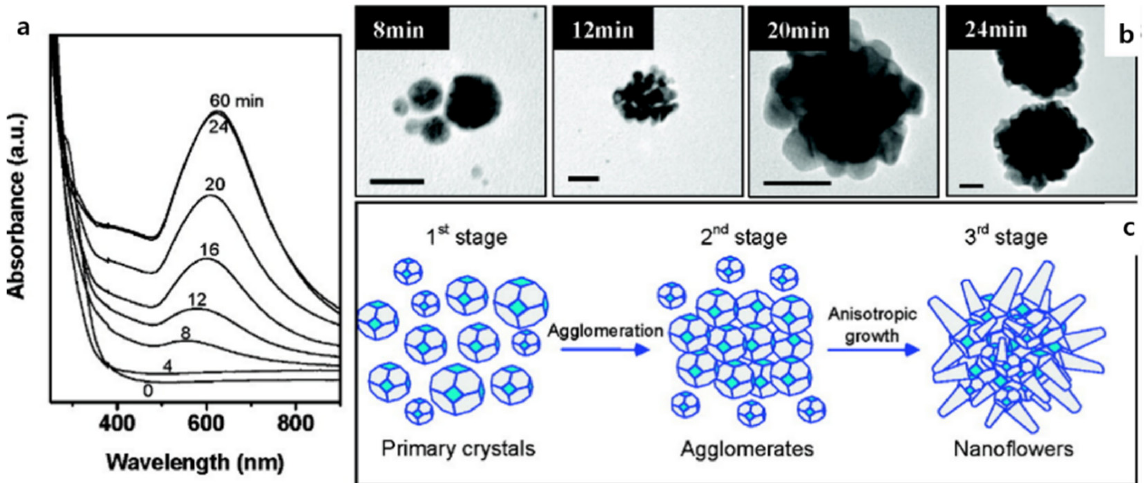
Figure 5. ( a ) UV–vis spectra as a function of reaction time of aqueous AuCl 4– solution (0.5 mM) and HEPES (10 mM). ( b ) Representative TEM images of the products harvested after 8, 12, 20, and 24 min of reaction time. All scale bars are 20 nm. ( c ) Schematic of the proposed mechanism for the formation of Au nanoflowers in HEPES solution. Reprinted with permission from Ref. [52]. Copyright 2008, American Chemical Society.